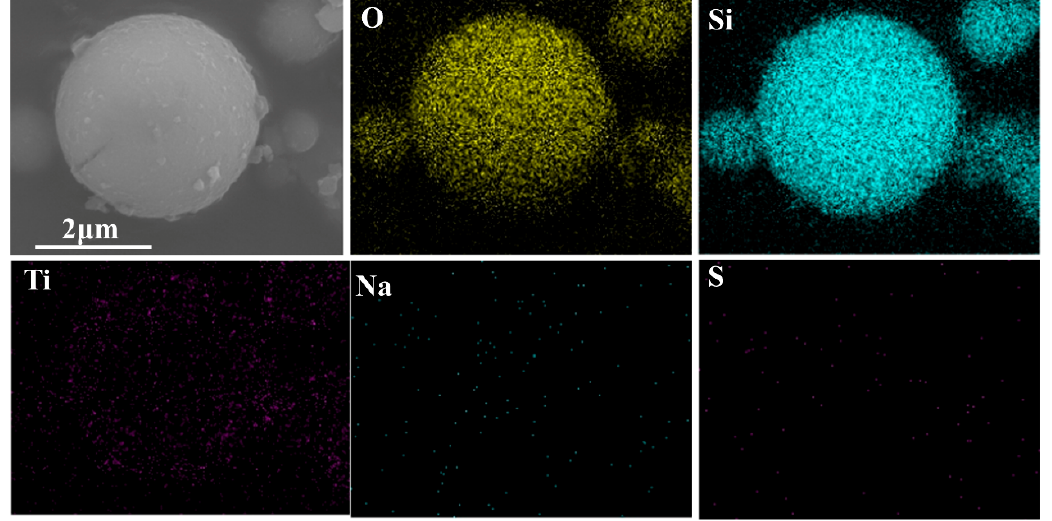
Figure 8. Element distribution of O, Si, Ti, Na, and S of 0.6-SiO 2 -M-7.5/TiO 2 .